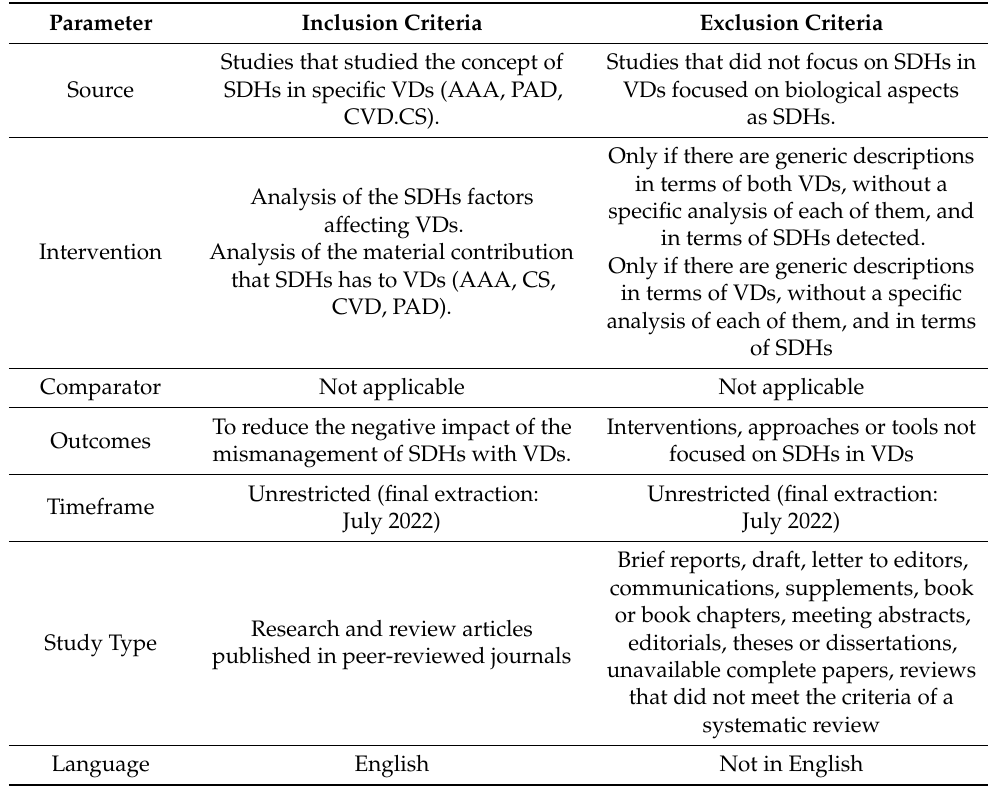
Table 2. Criteria for articles’ inclusion/exclusion according to a modified